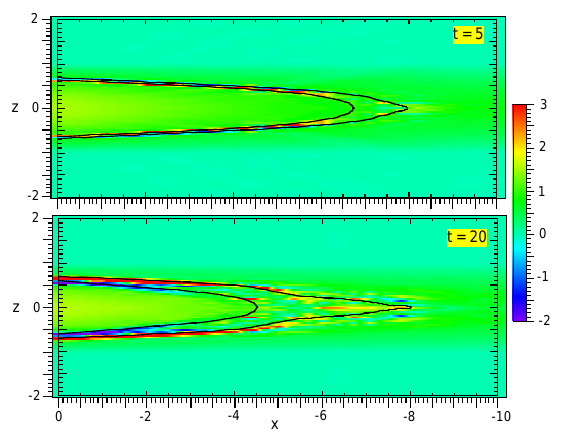
Fig. 7. Current density in the plane y = 0 at t = 5 and t = 20 for the same run as in Fig. 5.